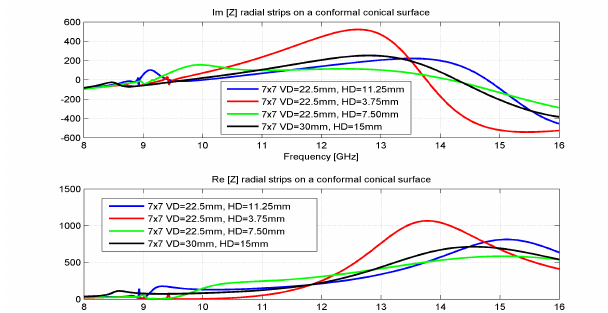
Fig. 16. Imaginary part (top panel), and real part (bottom panel) of Z A of a wire surrounded by identical passive ones for the geometry of Fig. 4 with different spacings. (VD stands for the Vertical Distance and HD is for Horizontal Distance between the wire centers).